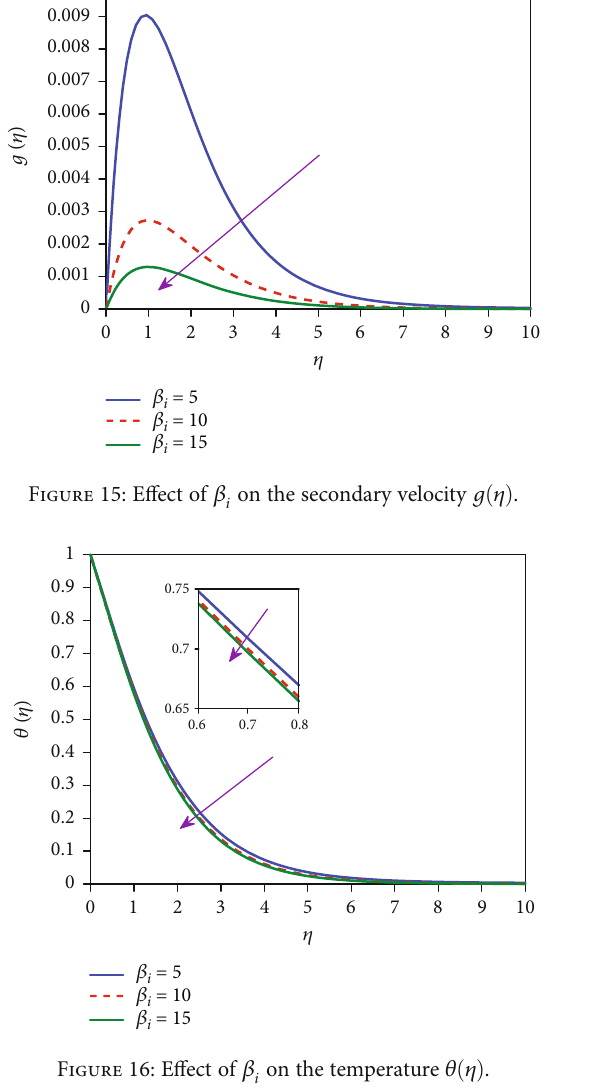
Figure 18: E ff ect of λ on the primary velocity f ′ ð η Þ .